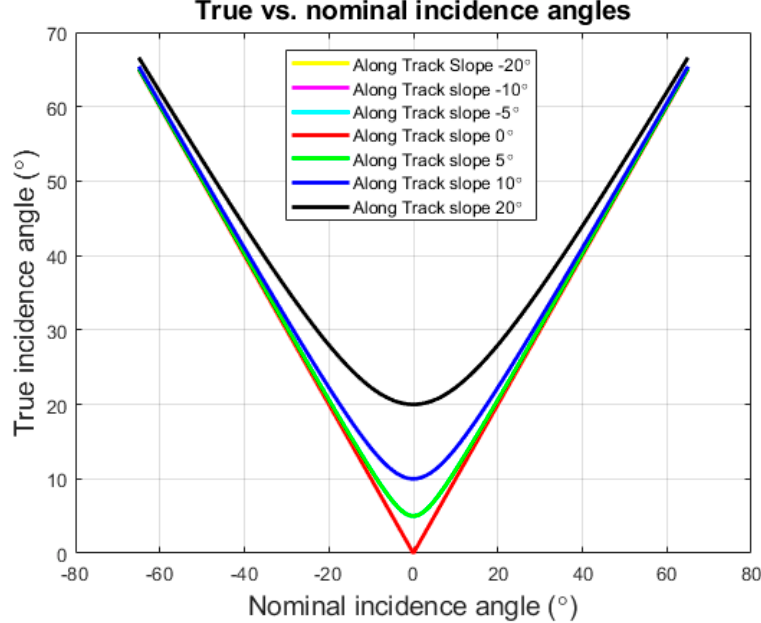
Figure 8. Effect of the along-track slope on the seafloor incidence angle, computed for various across-track, Tx , angles relative to nadir. Across-track slope is assumed as 0°.